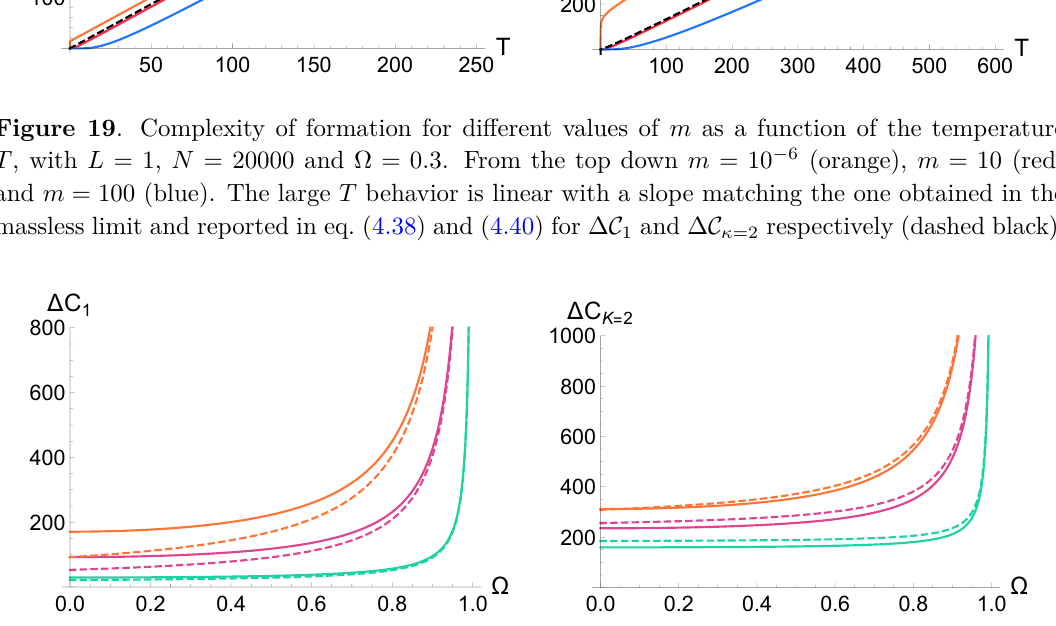
Figure 20 . Complexity of formation as a function of the angular velocity Ω . For any curve, L = 1 , N = 20000 and m = 10 − 6 . From the bottom up: T = 10 (solid green), T = 50 (solid pink) and T = 100 (solid orange). Dashed curves represent the Ω → 1 divergences plus the zero-mode divergence obtained analytically in (4.41) and (4.42). Notice that the complexity of formation evaluated with the two costs approach the limiting value from opposite directions.